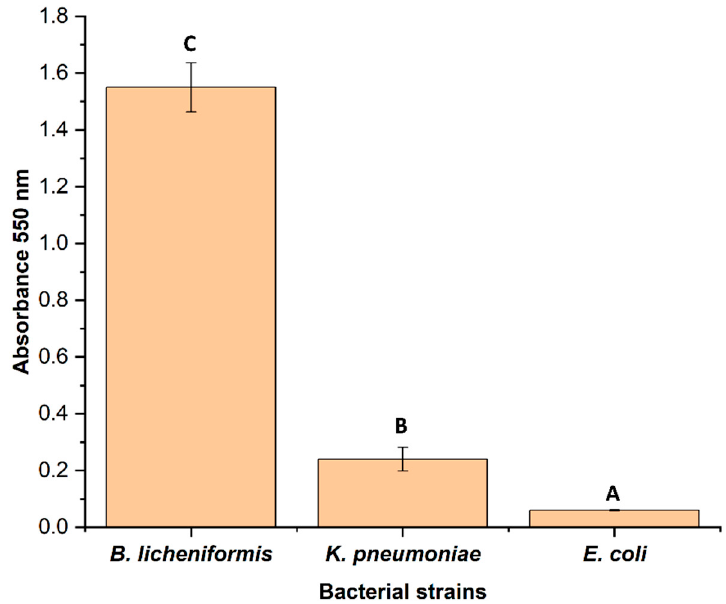
Figure 5. Biofilm forming capabilities of these test bacteria on the surface of wells of microtiter plate. Bars having different alphabet letters are statistically different.